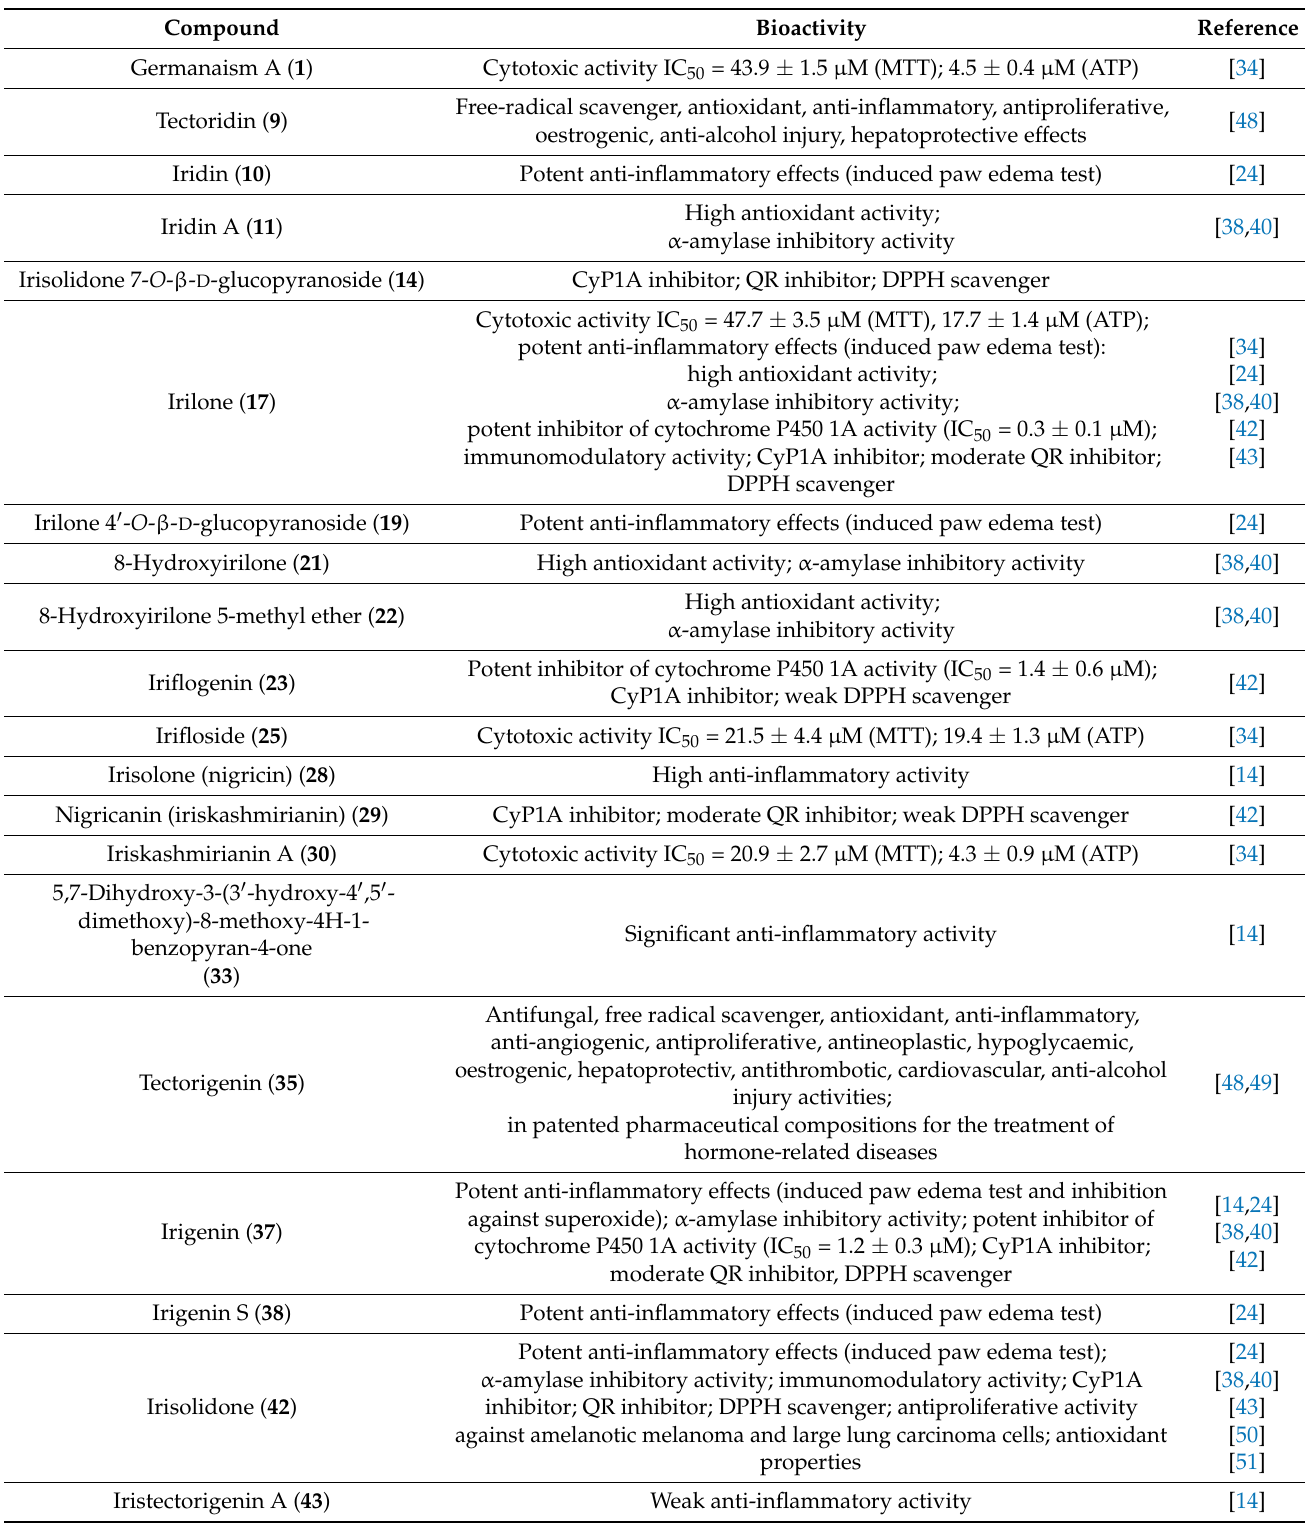
Table 1. Biological activities reported for the isoflavonoids isolated from Iris germanica